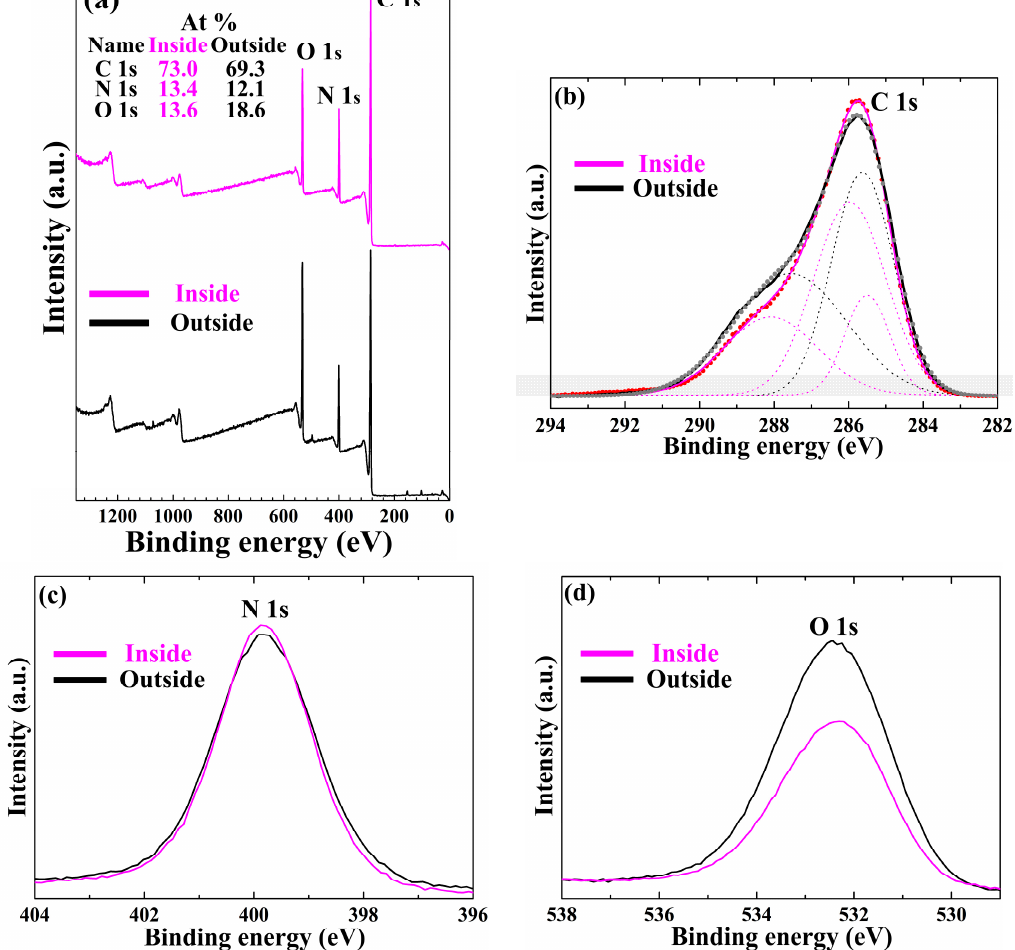
Figure 6. Differences in the inside and outside cases of pPPy nanofibers and nanoparticle thin film prepared using proposed APPJs after a deposition of 60 min on glass substrates. ( a ) X-ray